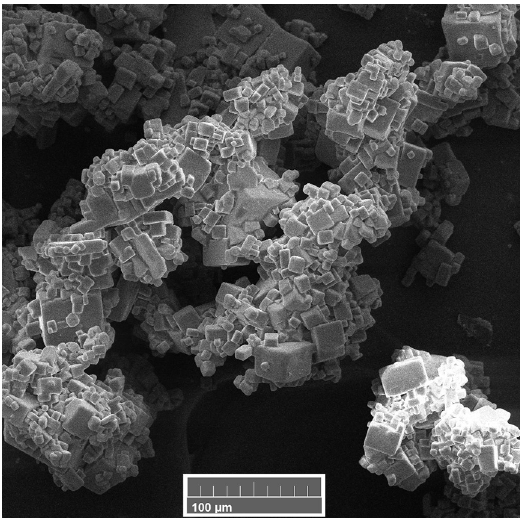
Figure 6. Scanning electron microscopy of the crystals obtained in experiment 1.